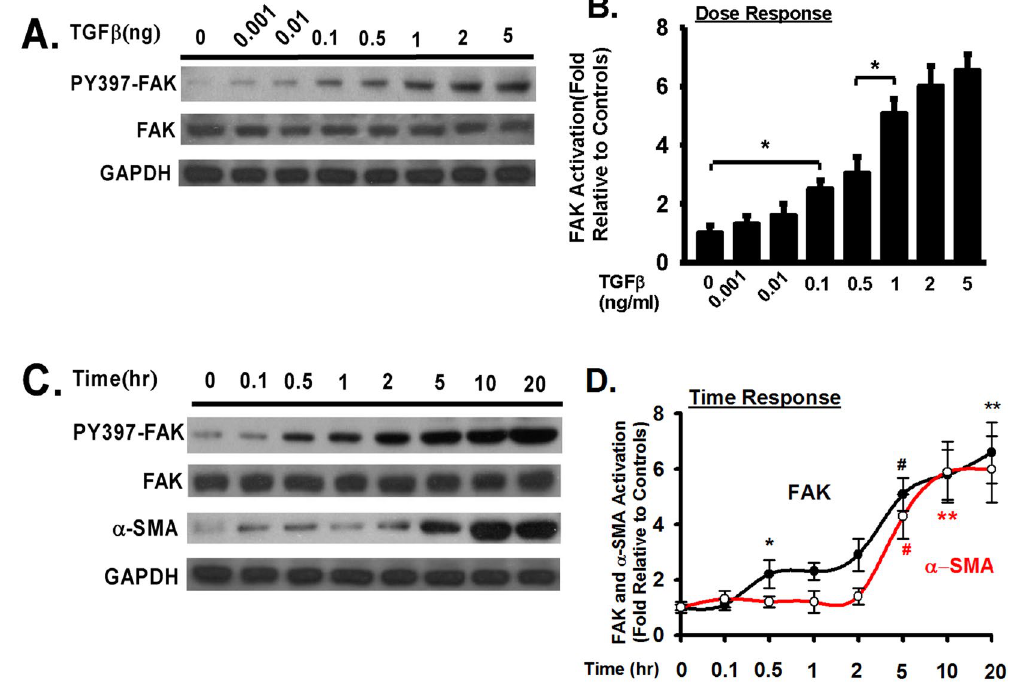
Figure 2. Transforming growth factor beta-1 (TGF- β 1) induces FAK activation in a dose- and time-dependent manner in primary hepatic stellate cells (HSCs); FAK activation precedes α -SMA expression in HSCs. ( A ) Primary mouse HSCs were serum starved for 20 hours, treated with TGF- β 1 at the indicated dose (ng/ml) for 24 hours, and lysed. Equivalent amount of whole cell detergent lysates were western blotted with the indicated antibodies for phosphorylation of Y397 of FAK (FAK activation), total FAK, or GAPDH. ( B ) Densitometry analysis of phosphorylation of Y397 of FAK (normalized to total FAK) at the indicated TGF- β 1 dose. ( C ) Primary mouse HSCs were serum starved for 20 hours, treated with TGF- β 1 (2 ng/ml) for the indicated time periods (hour, hr), and lysed. Equivalent amount of whole cell detergent lysates were western blotted with the indicated antibodies. ( D ) Densitometry analysis of the association of phosphorylation of Y397 of FAK (normalized to total FAK) and α -SMA at the indicated time in response to TGF- β 1 stimulation. Data were pooled from at least three independent experiments and represented as mean ± SE. * p represents < 0.05. # or ** represents < 0.01 when compared to time